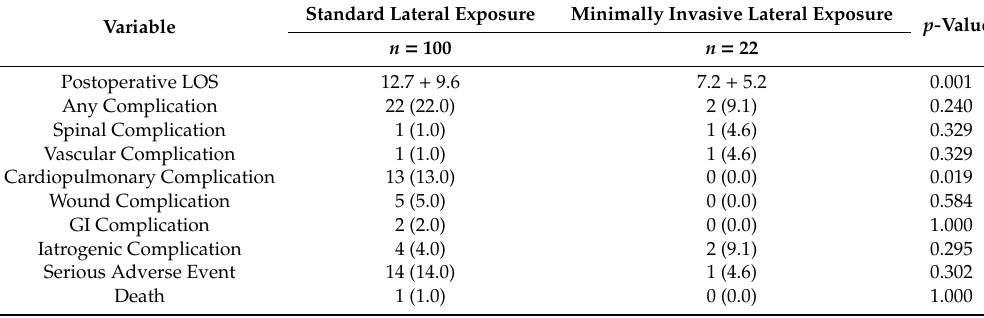
Table 3. Outcomes † .